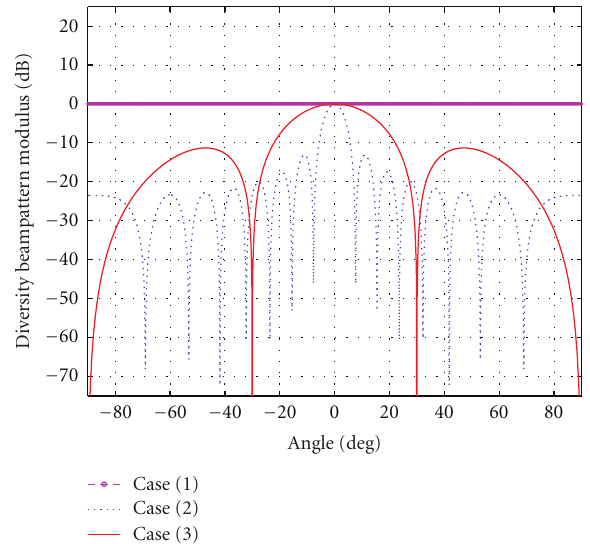
Figure 2: The comparative transmit beampatterns when Δ f = 0. Figure 3: The comparative diversity beampatterns when Δ f = 0.